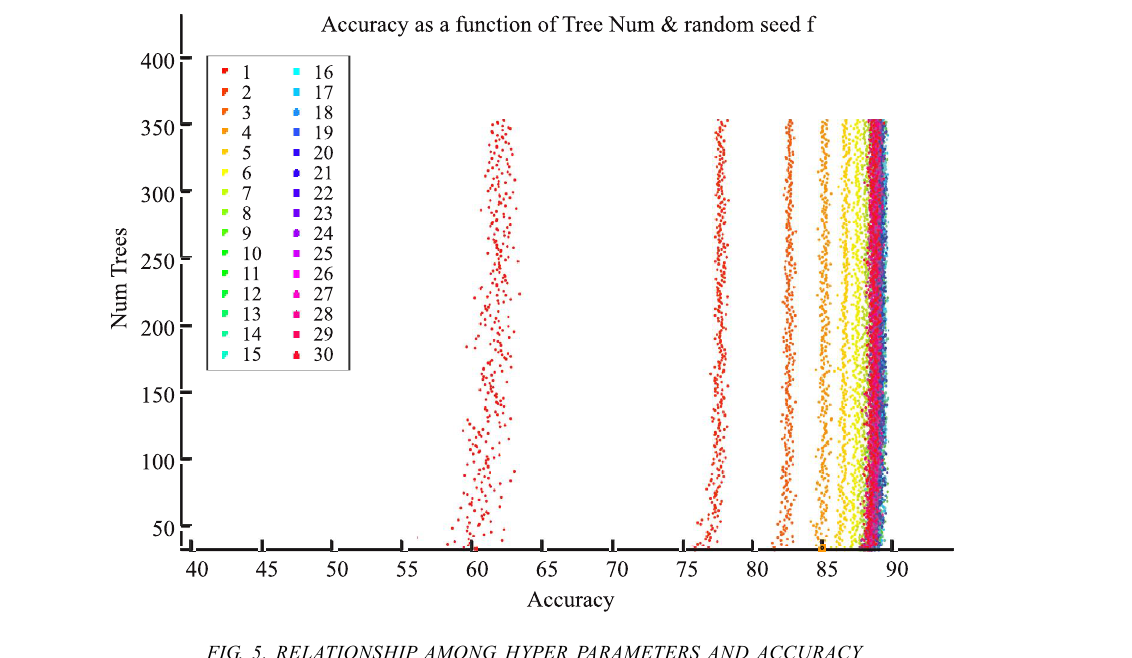
FIG. 5. RELATIONSHIP AMONG HYPER PARAMETERS AND